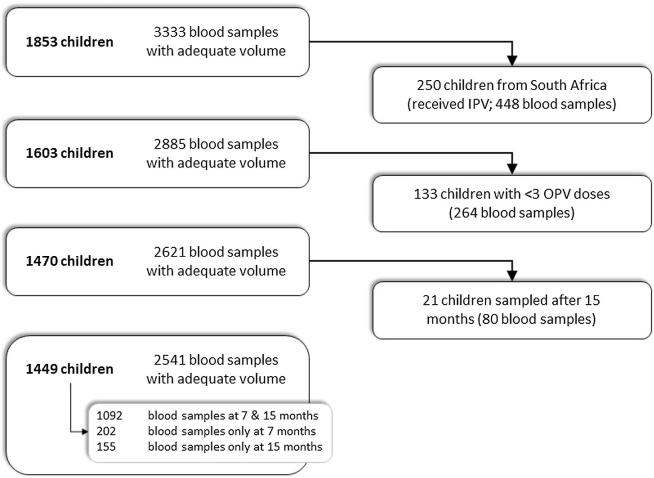
Child samples selected for OPV response study. Blood sample collection from each child was scheduled at seven and 15 months of age. All blood samples with sufficient volume were tested for poliovirus serotype 1, 2, and 3 serum neutralizing antibody assays. Children administered inactivated poliovirus vaccines were excluded, all of whom were from the MAL-ED cohort study site in South Africa. Blood samples collected from children receiving less than three documented doses of oral poliovirus vaccine prior to the date of blood collection were also excluded. The 2541 samples included in this analysis represent 1449 children from seven MAL-ED cohort study sites. 1092 of 1449 children (75%) contributed samples at both time points.